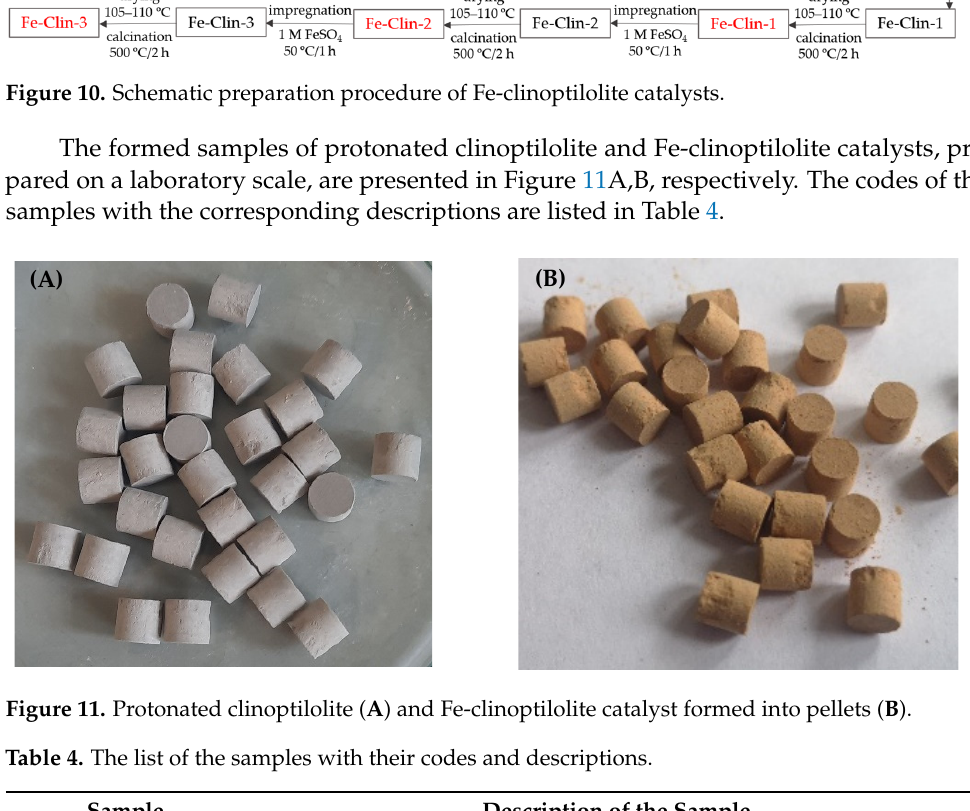
Table 4. The list of the samples with their codes and descriptions.